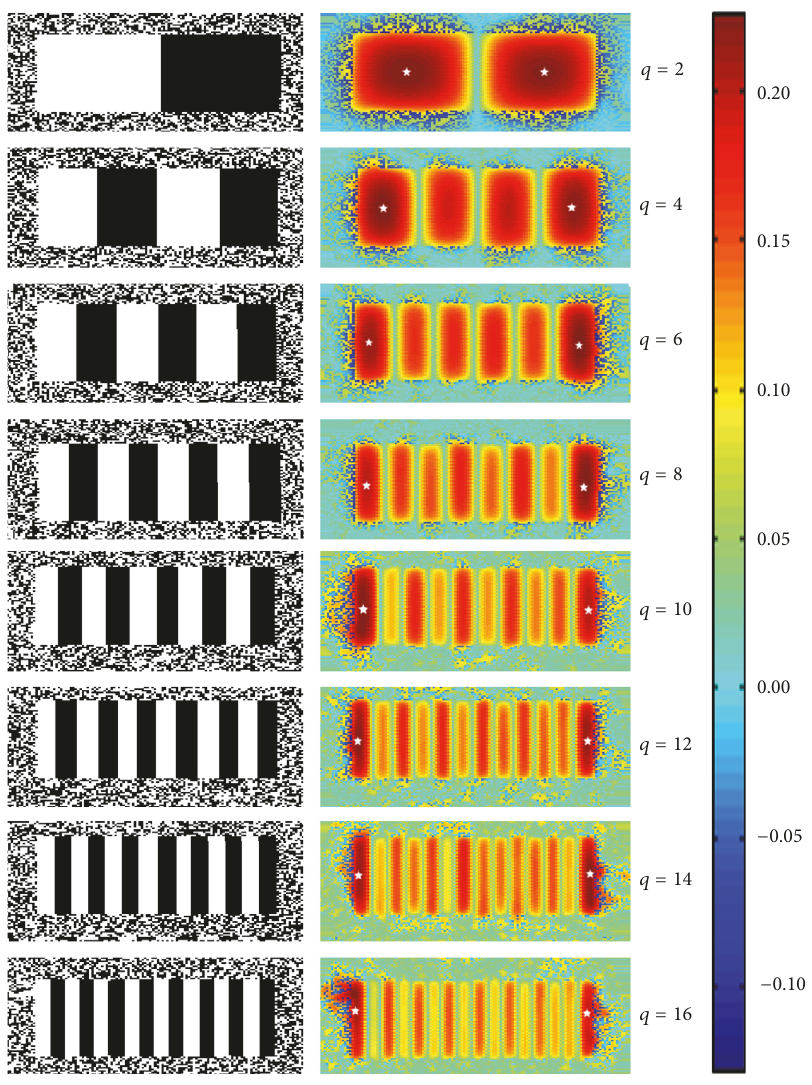
Figure 4: Configurations with increasing number 𝑞 of equal bars (narrowing the width 𝑤 𝑖 ≈ 𝑆/𝑞 for all bars). To the left the magnetic sectors are defined schematically. To the right the actual energy map is presented with reddish colors for the most repulsive areas: a palette code is given to the far right. White stars identify the points with maximum repulsive